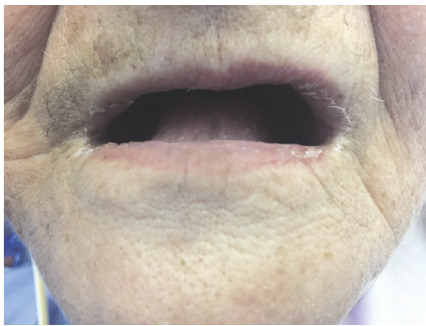
Figure 1: Maximum lip-to-lip mouth opening size of 12 mm on admission day 28. The patient was initially unable to speak or